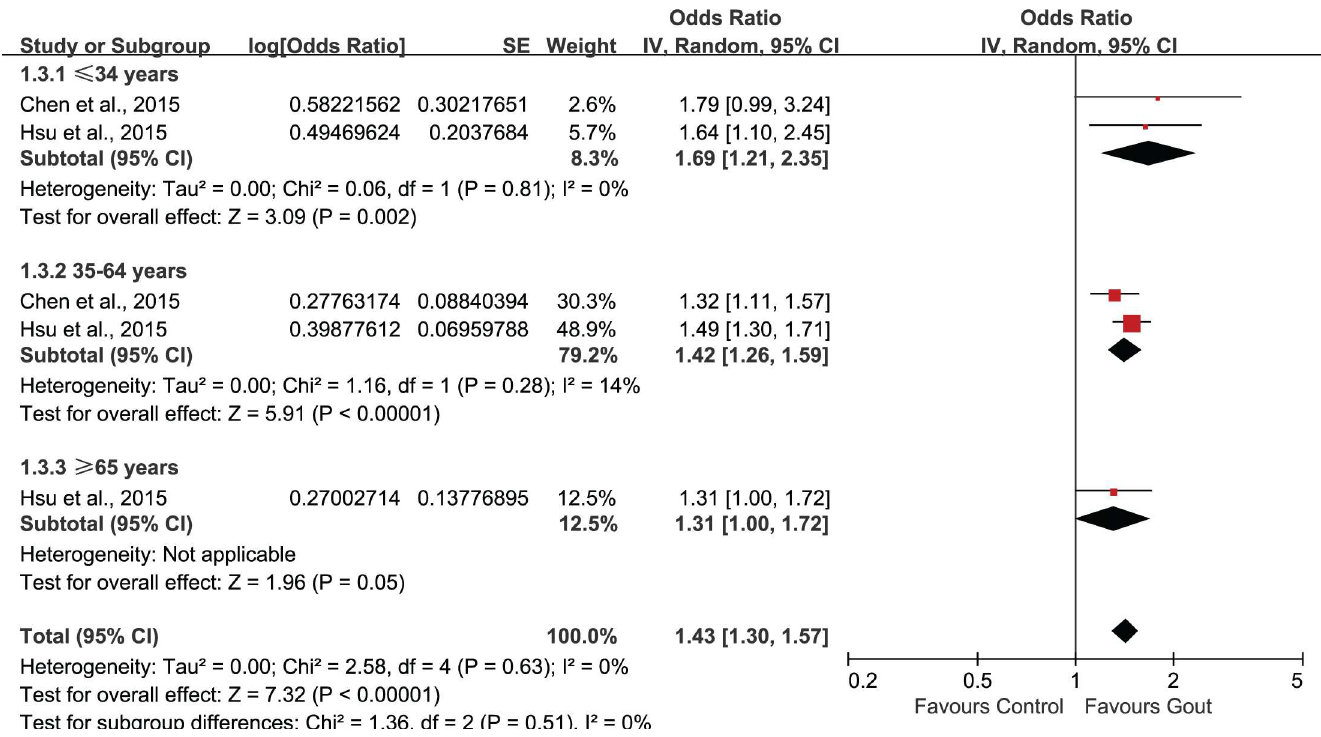
Fig 4. Subgroup-analysis based on age.